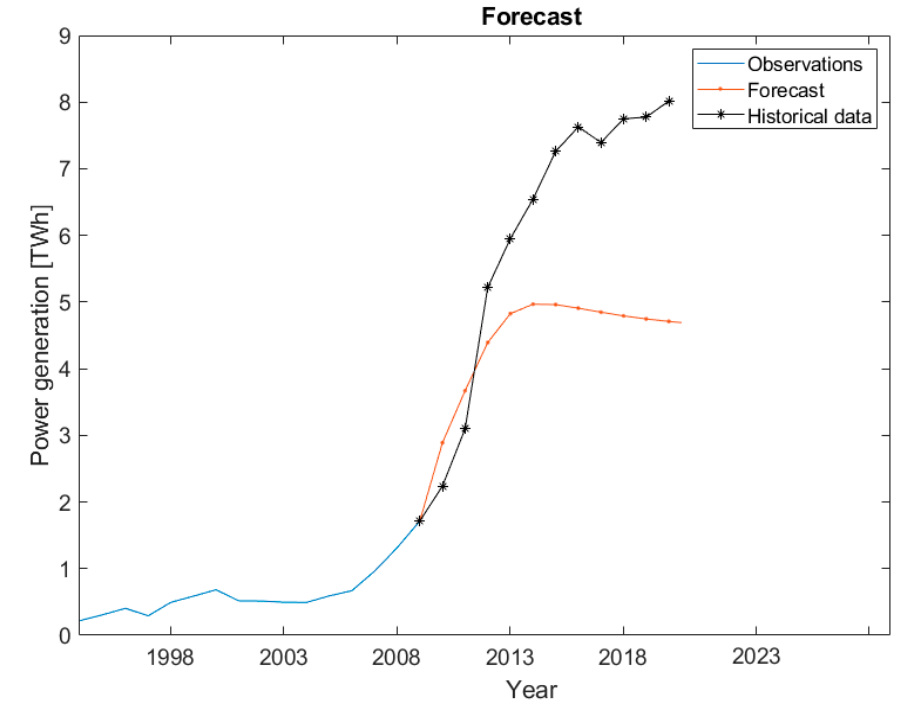
Figure 8. Prediction for renewable energy production with basic financial aid.